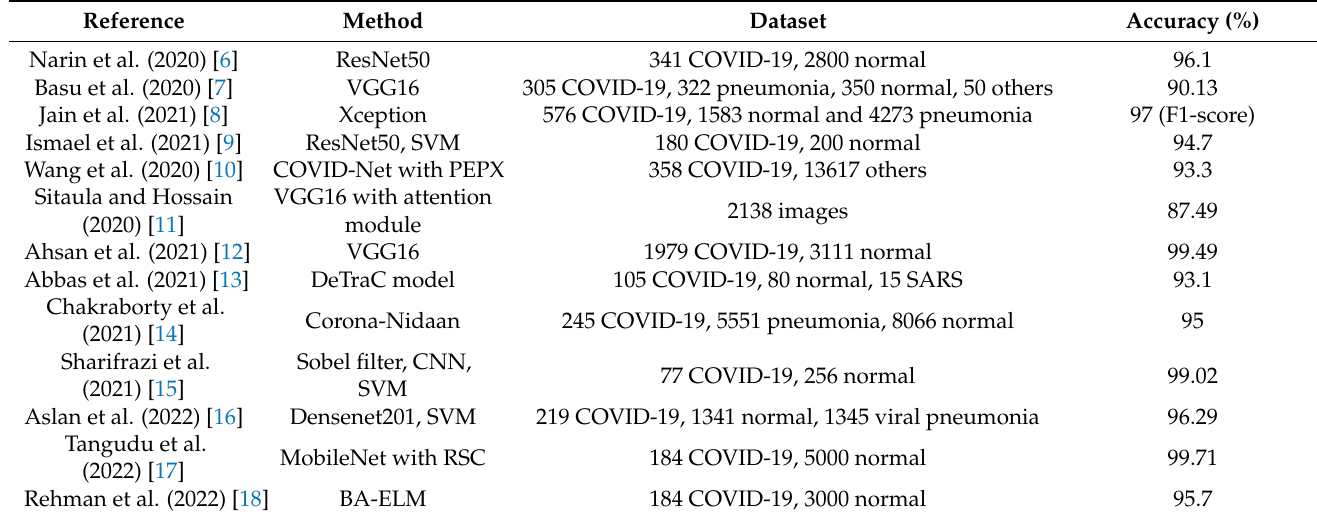
Table 1. The summary of the existing works on COVID-19